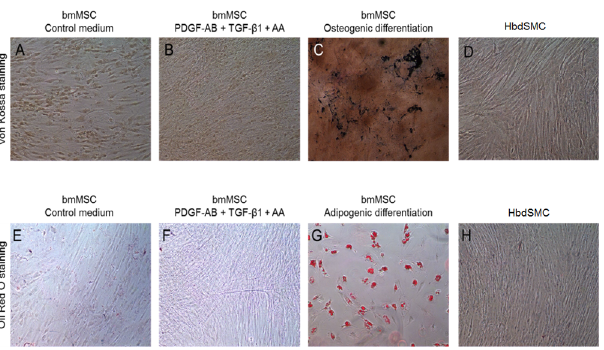
Fig 5. Determination of osteogenic and adipogenic differentiation. MSCs were cultured in control medium, SMC differentiation medium, osteogenic differentiation medium or adipogenic differentiation medium as indicated for 14 days. HbdSMCs were cultured in SMC medium (smooth muscle cell growth medium 2). Osteogenic differentiation was assessed by Von Kossa staining (A-D) and adipogenic differentiation by Oil Red O staining (E-H). Magnification 20x. Representative of n =